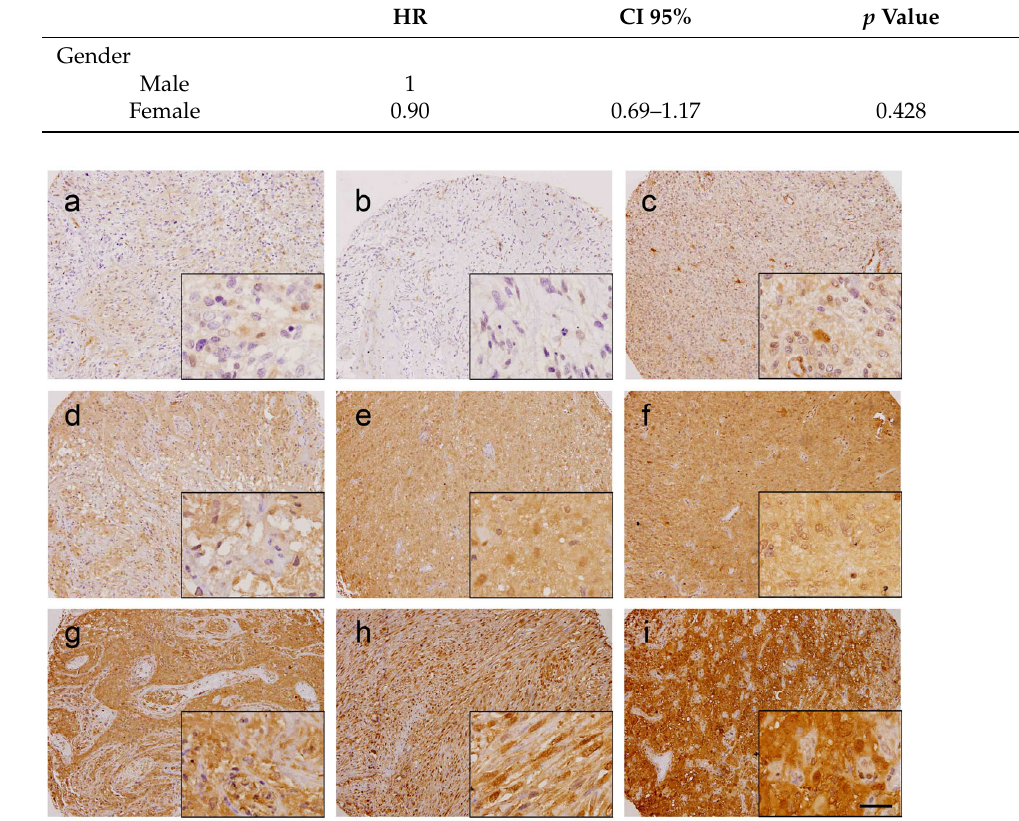
Figure 1. Gal-1 immunohistochemistry in glioblastoma tissue microarray (TMA). Representative Figure 1. Gal ‐ 1 immunohistochemistry in glioblastoma tissue microarray (TMA). Representative images of selected “low Gal-1” (panels ( a – c ), H-Score < 129.3) or “high Gal-1” (panels ( d – i ), H- images of selected “low Gal ‐ 1” (panels ( a – c ), H ‐ Score < 129.3) or “high Gal ‐ 1” (panels ( d – i ), H ‐ Score Score ≥ 129.3) glioblastoma cores are shown. Scale bar, 100 µ m (low magnification) or 25 µ m (high ≥ 129.3) glioblastoma cores are shown. Scale bar, 100 μ m (low magnification) or 25 μ m (high mag ‐ nification inserts). magnification inserts).